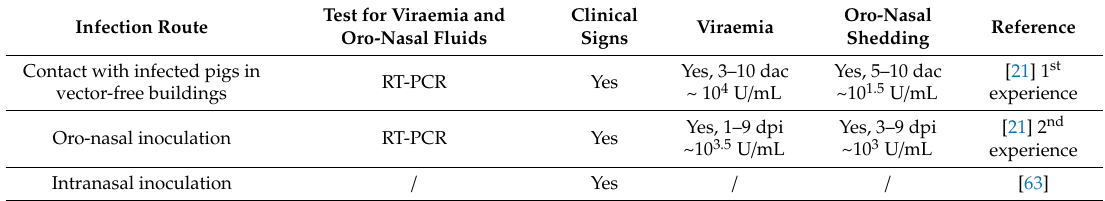
Table 5. Experimental evidence of JEV direct transmission between